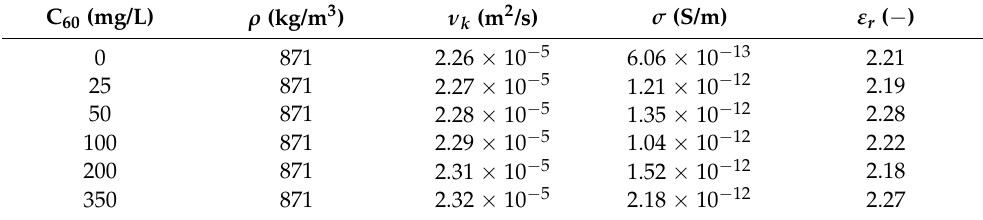
Table 1. Properties of C 60 fullerene doped fresh Trafo En mineral oil (20 ◦